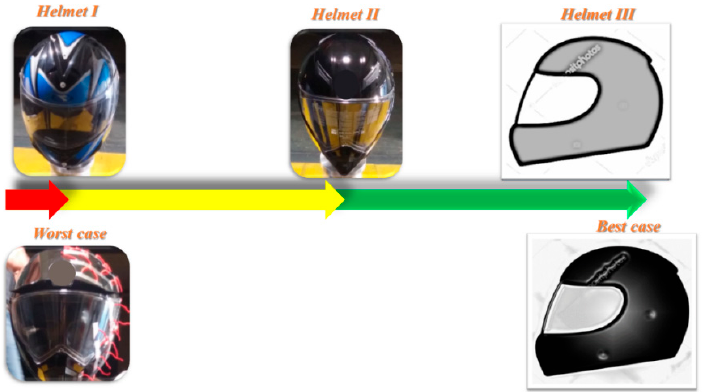
Figure 11. Quality index related to helmets compared with the references.